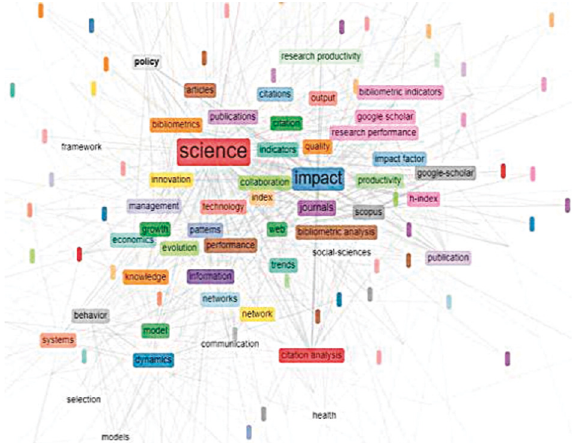
Figure 10: 2011–2015 cooccurrence